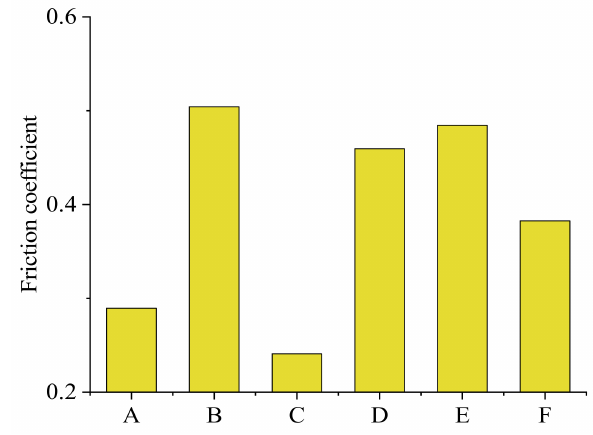
Figure 8. Average friction coe ffi cients for calcined